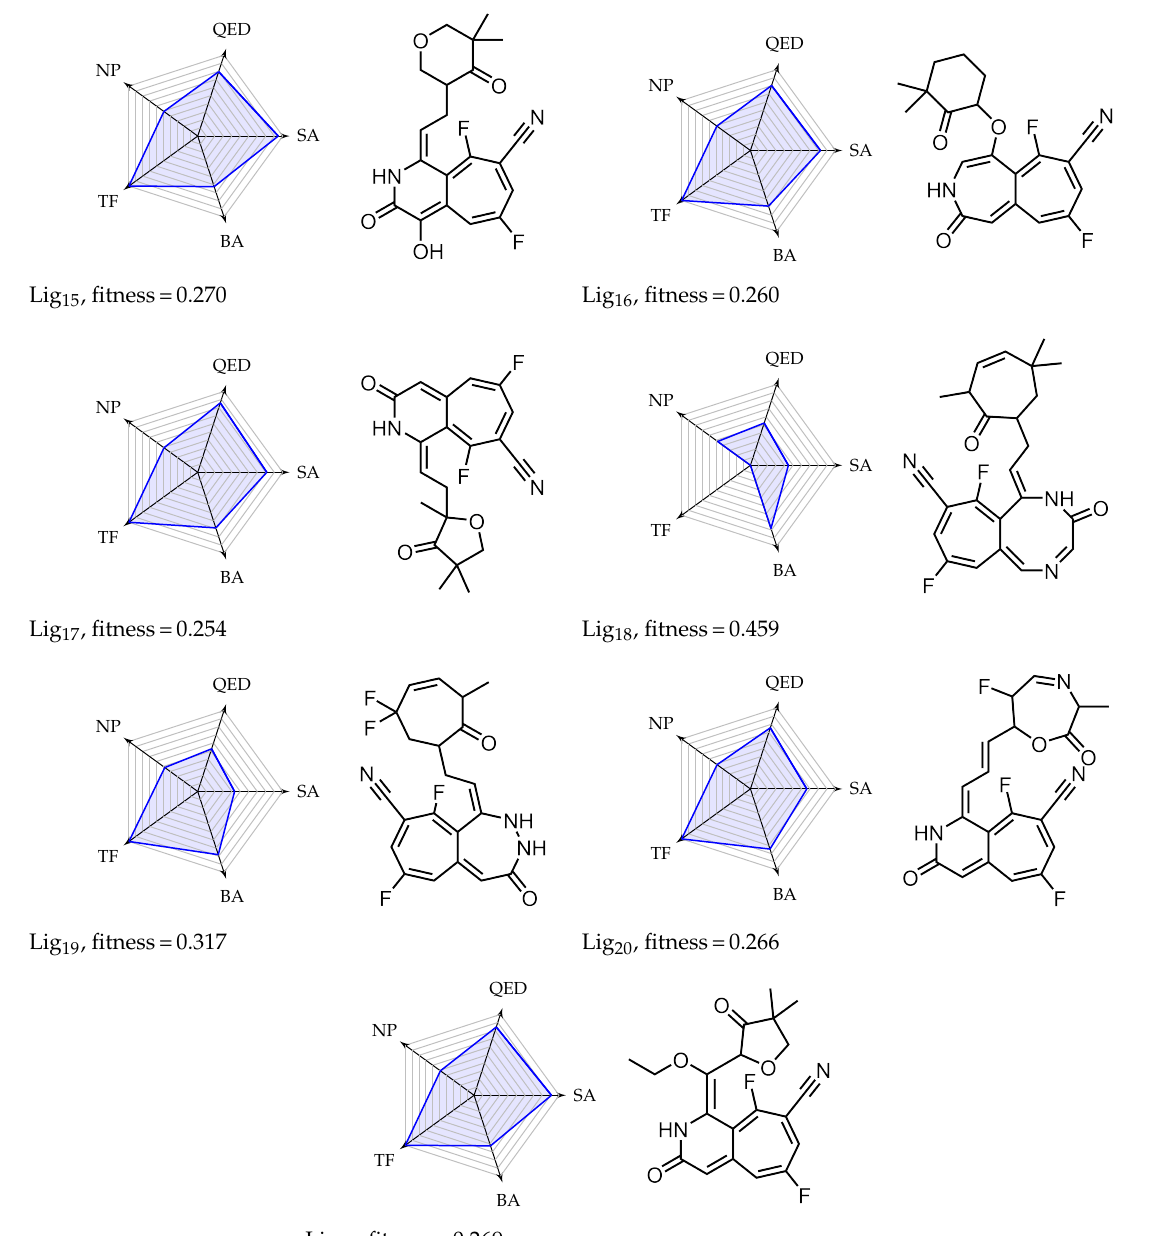
Figure A1. Molecular structures of simulated ligands. Radar plots show how well the ligands performed with respect to the five studied metrics. The best scores are on the edge of the radar plot and the worst scores are in the center.